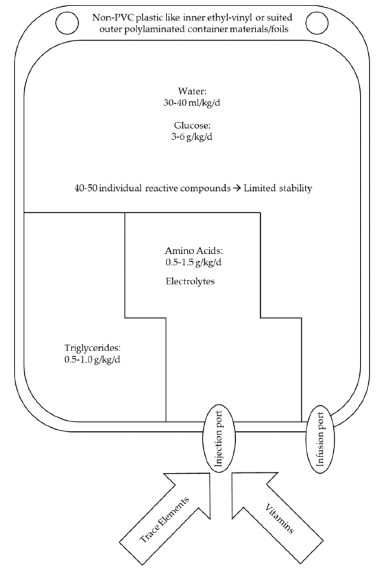
Figure 1. The all-in-one PN concept with adult nutrient requirement, adapted from [2].